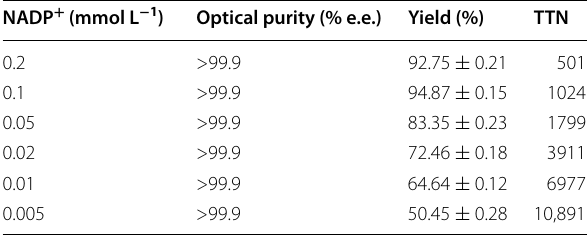
All reactions were carried out in 10 mL TEA buffer (0.1 mol L − 1 , pH 8.4) comprising 20 g L − 1 DKTP with addition of 100 g L − 1 glucose at 40 °C and 200 rpm for 10 h. All the results were the average of three parallel replicates